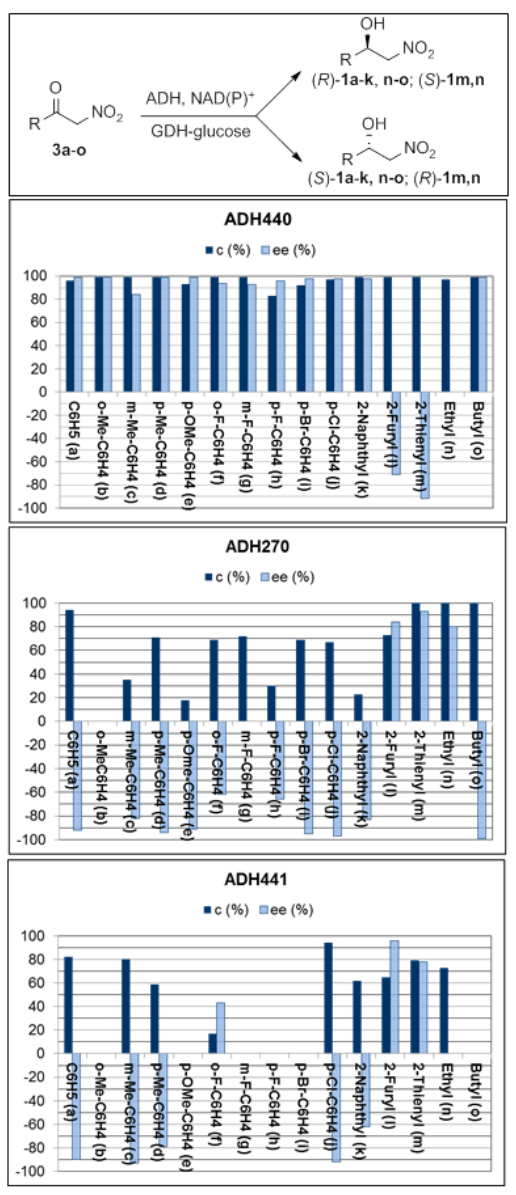
Figure 1. Alcohol dehydrogenases (ADH)-mediated reduction of nitroketones 3a – o to nitroalcohols